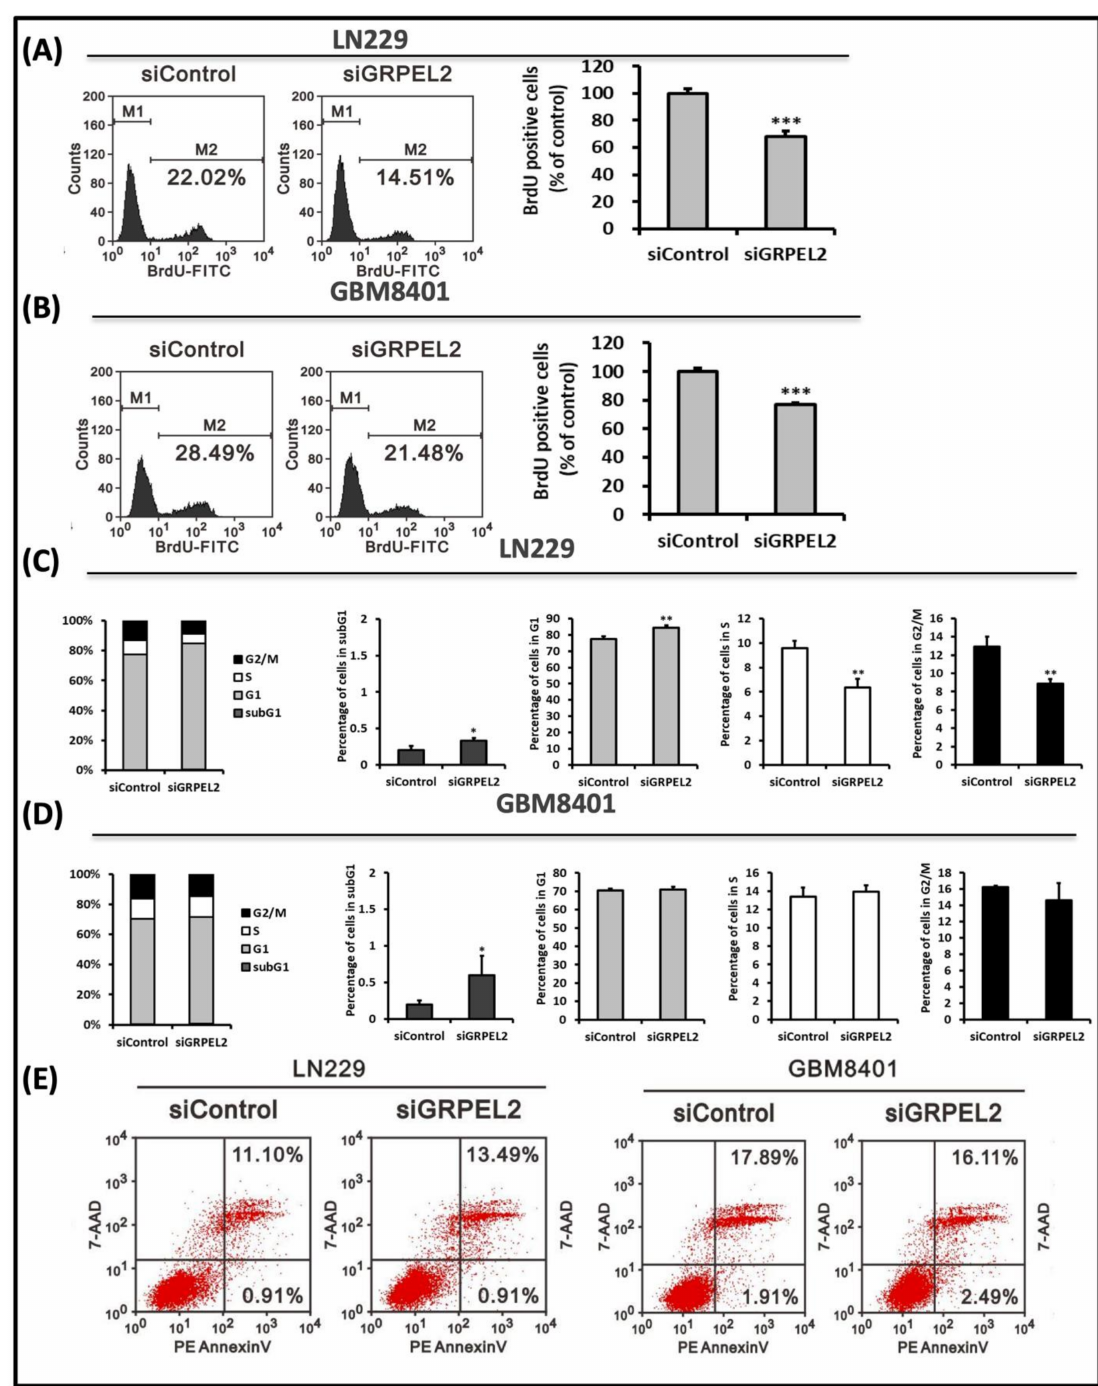
Figure 5. Effect of siGRPEL2 on cellular proliferation and apoptosis of LN229 and GBM8401 cells. ( A , B ) FITC-labeled anti-BrdU staining of LN229 ( A ) and GM8401 ( B ) cells after incubation with siControl and siGRPEL2 at 25 nM concentration analyzed by flow cytometry. M1 corresponds to the negative control and M2 to the positively stained cells (cell fractions expressed in percentage). Percentage of BrdU positive cells after treatment with siControl and siGRPEL2 of LN229 cell lines. *** p < 0.001. ( C , D ) The cell cycle profiling of LN229 ( C ) and GBM8401 ( D ) cells was shown. Note that GRPEL2 suppression increased cell fraction in the subG1 phase in both LN229 cells ( C ) and GBM8401 cells ( D ). * p < 0.05; ** p < 0.01. ( E ) Flowcytometric apoptosis assay of LN229 and GBM8401 cells treated with siGRPEL2 after 7-AAD/PE Annexin V staining. The apoptotic cells (early and late stages) were detected by FCS and represented as a percentage. The data are representative of two independent